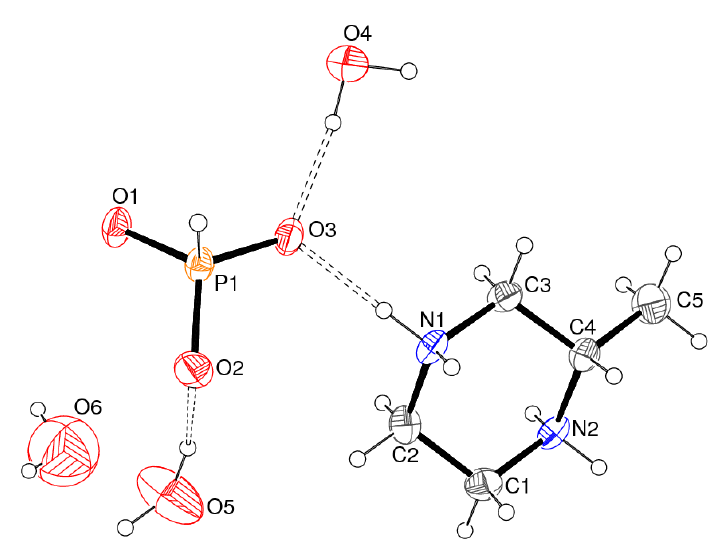
Figure 3. The molecular structure of 2 showing 50% displacement ellipsoids. The N1–H1c L O3, double-dashed